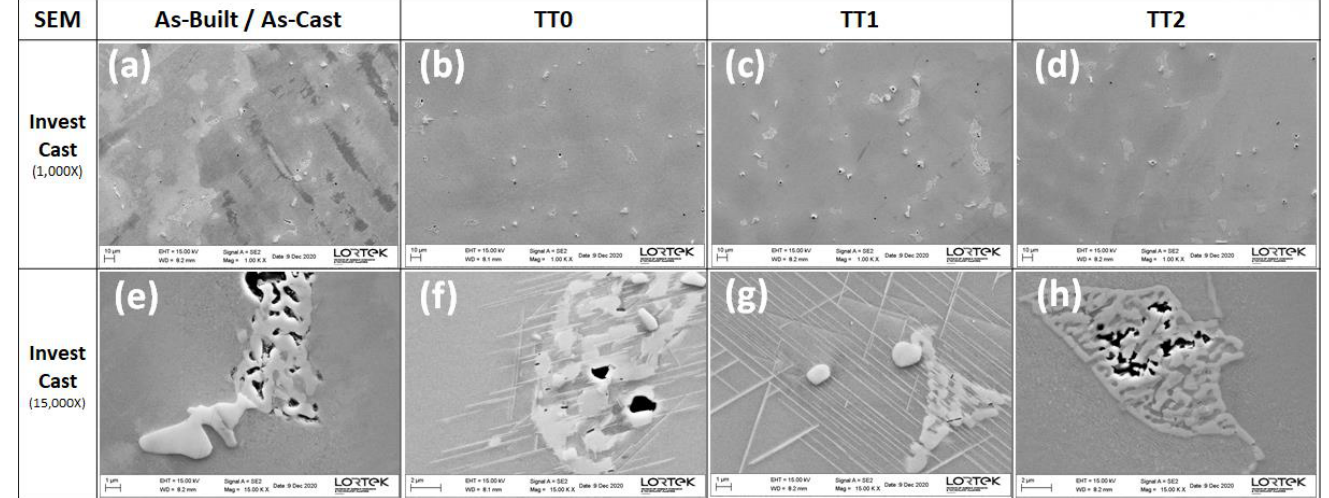
Figure 10. FESEM micrographs for IN718 investment casting in As-cast and heat-treated conditions. ( a – d ): Investment casting samples at low magnification, and ( e – h ): Investment casting samples at high magnification. (samples not etched, only polished).